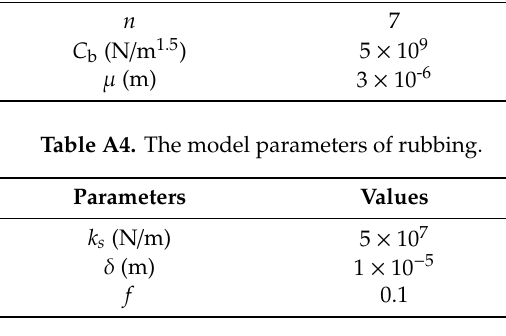
Table A5. The model parameters of spline